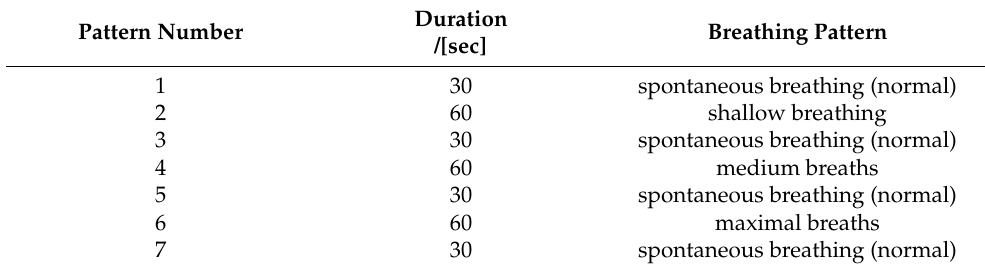
Table 2. Respiratory